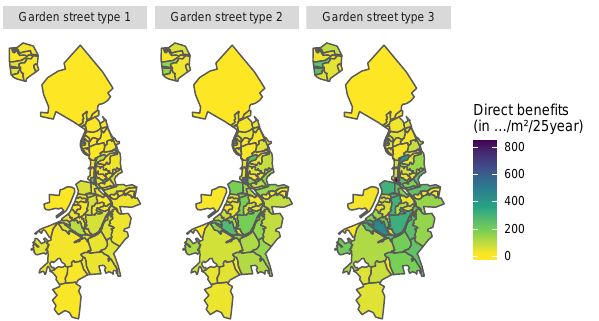
Figure 6. The direct benefits of proposed garden streets can be derived by the modelled financial benefit for each type of garden street within the different hydrological catchments of the city. Antwerp end-users.